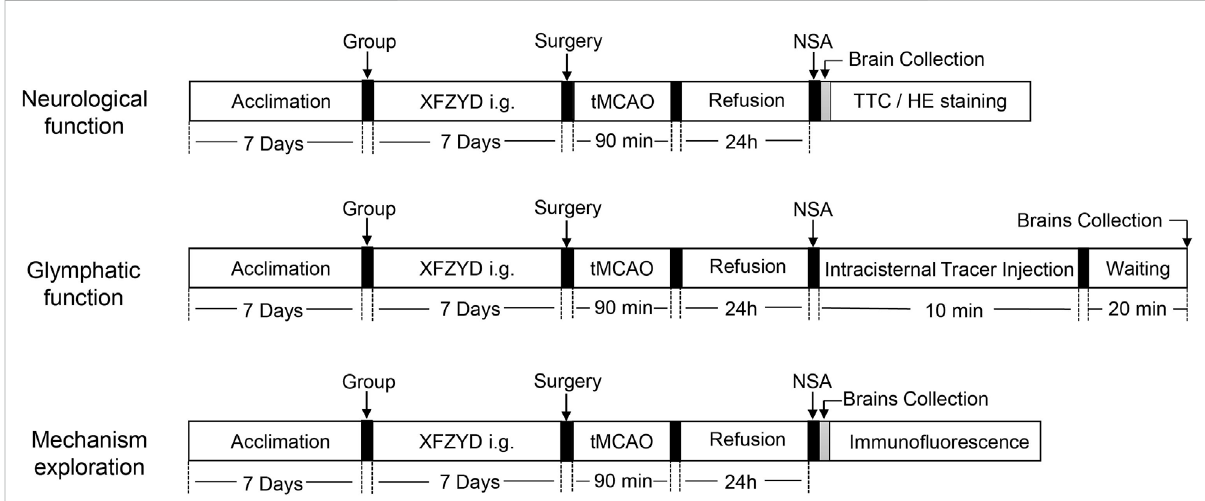
FIGURE 1 Schematic diagram depicting the entire study. Three experiments were carried out; these were designed to investigate the effect of XFZYD pretreatment on neurological function, glymphatic function and identify the potential mechanisms involved. XFZYD, Xuefu Zhuyu